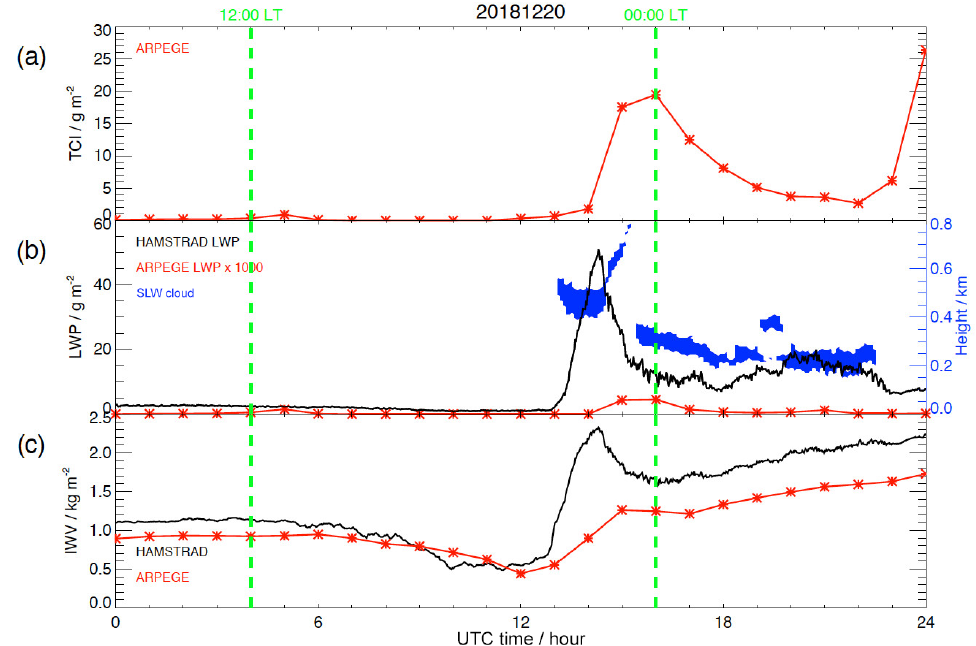
Figure 11. Same as Fig. 4 but for 20 December